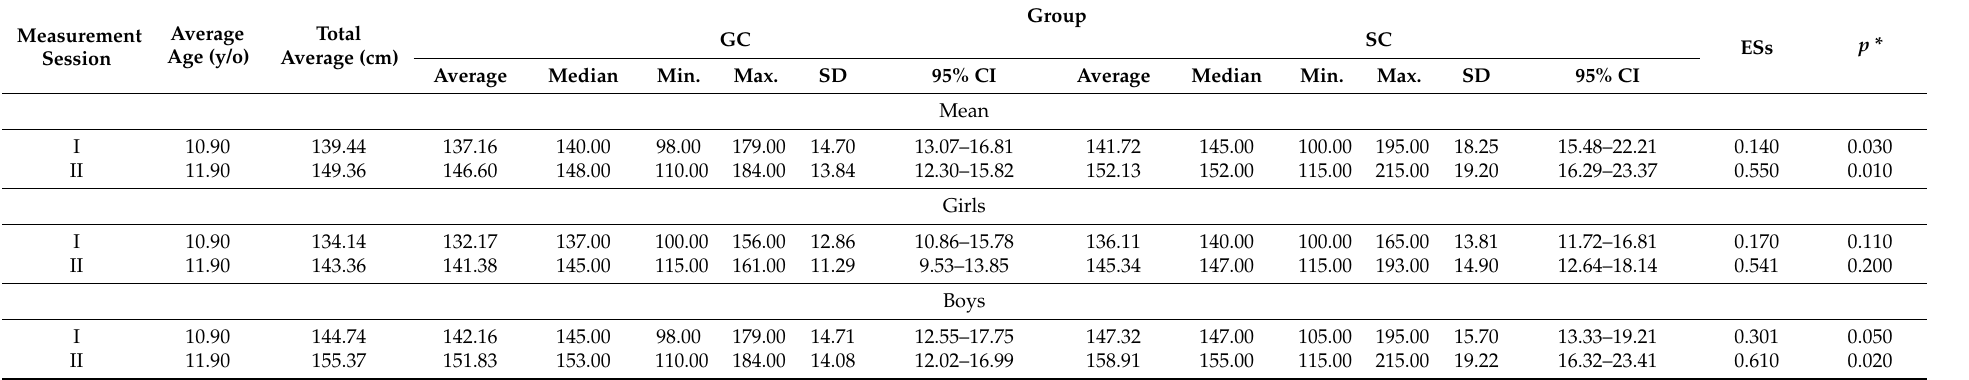
Table 2. Results of the long jump test from a standing position,